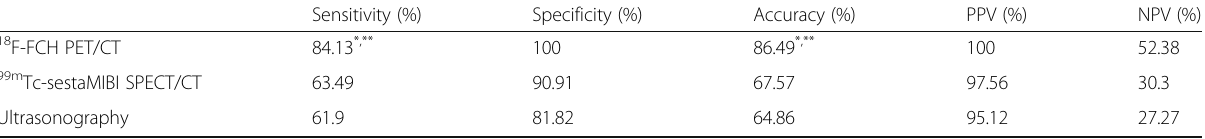
Table 2 Diagnostic performance of 18 F-fluorocholine PET/CT and conventional imaging